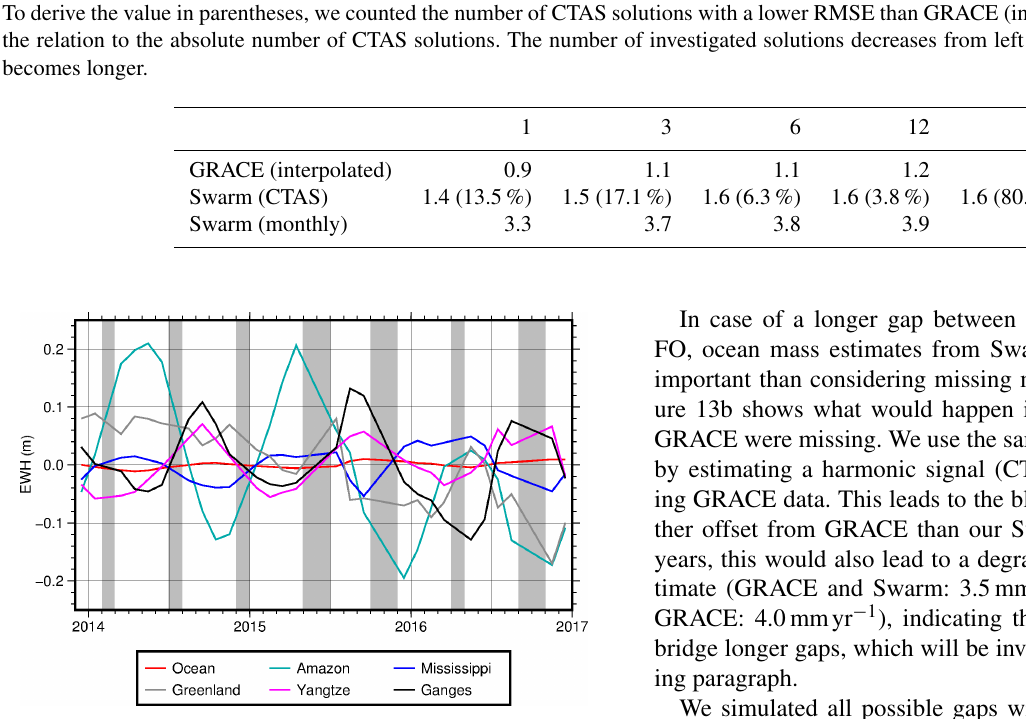
Figure 12. EWH derived from GRACE (d/o 12, 500km Gaussian filter) for different regions. The time series have been reduced by their mean values for reasons of